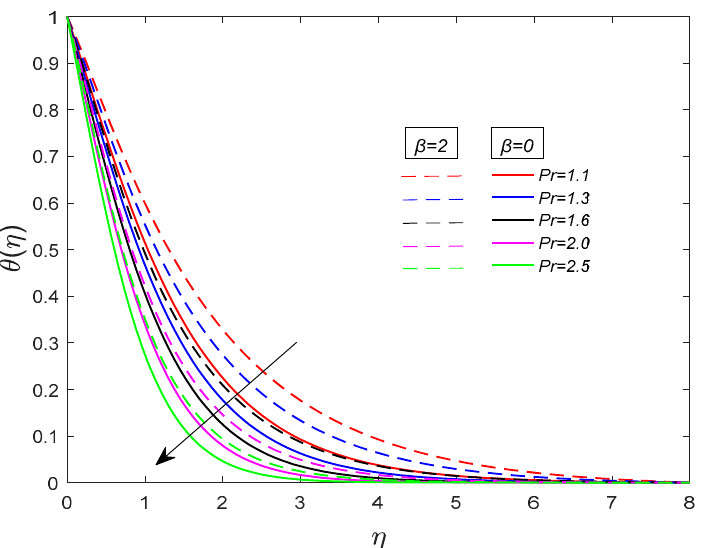
Figure 12. Effect of the Prandtl number (Pr) on thermal profile with Ec = M = Kr = Sc = 0.5, Sr = 1.5.